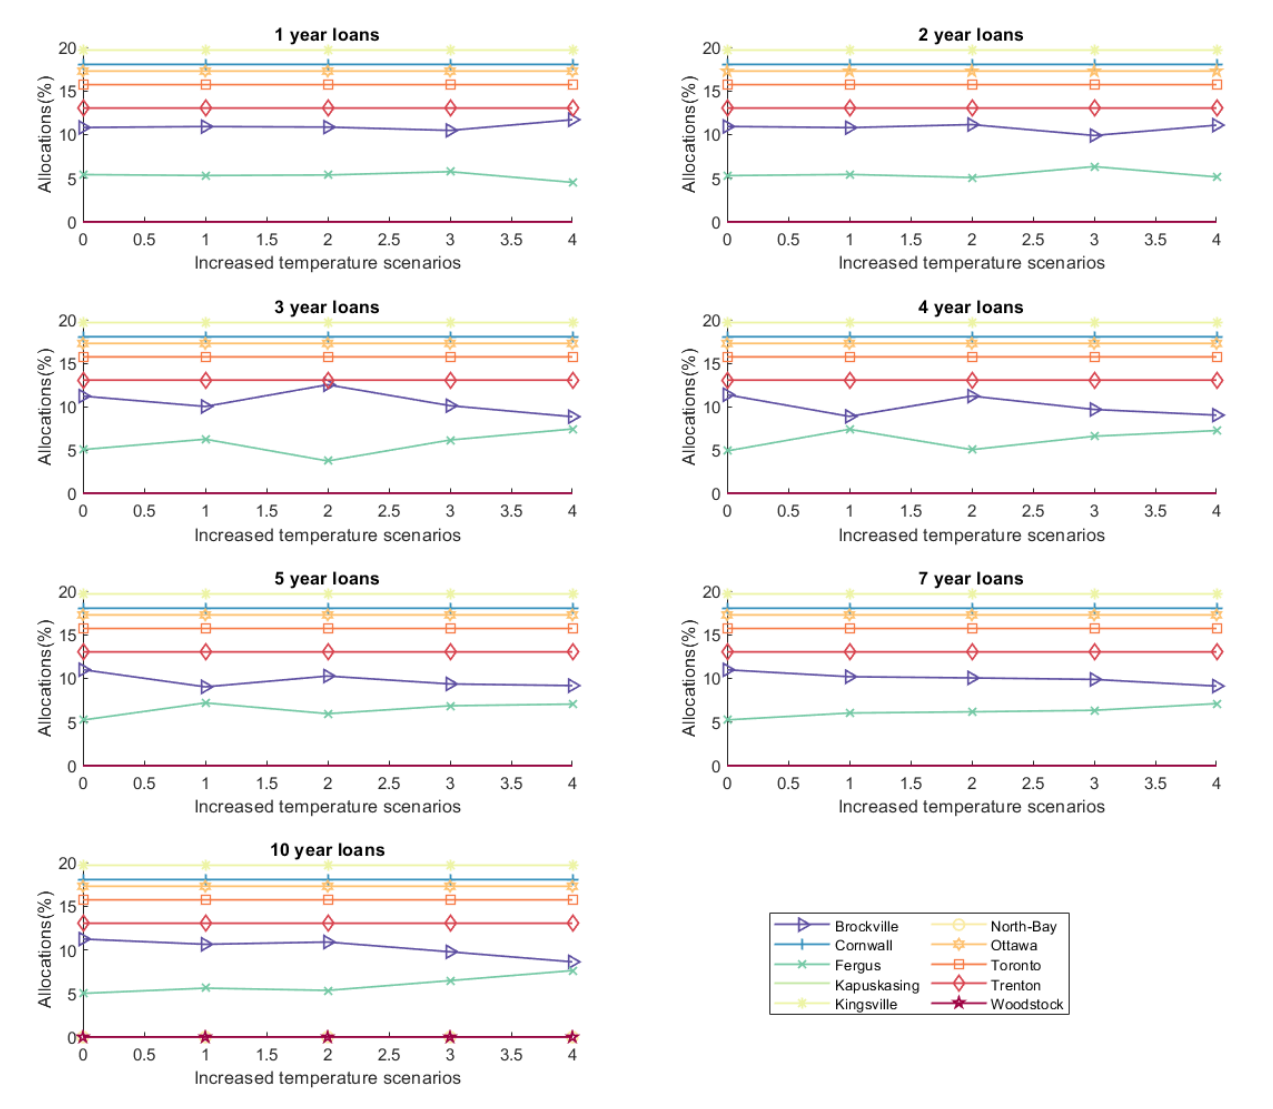
Figure 6. Allocations to each region when entire budget is invested in one type of loan under five different 1 ◦ C increased temperature